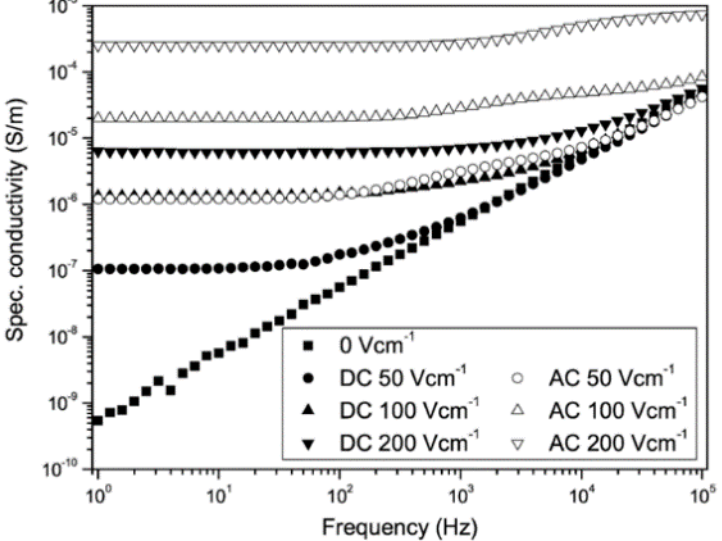
Figure 40. AC conductivity as a function of frequency for fully processed bulk epoxy nanocomposites containing 0.01 wt.% MWCNTs exposed to AC or DC during curing. Reprinted from [112], Copyright 2005, with permission from Elsevier.